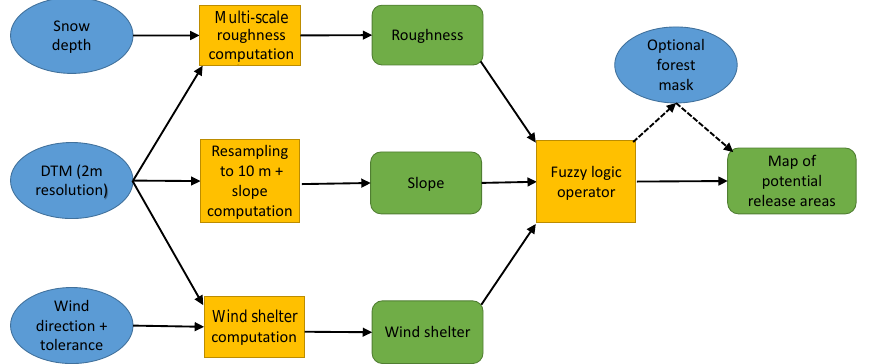
Figure 1. Schematic overview of the release area algorithm showing the input data (blue), processing steps (yellow) and output raster data (green).